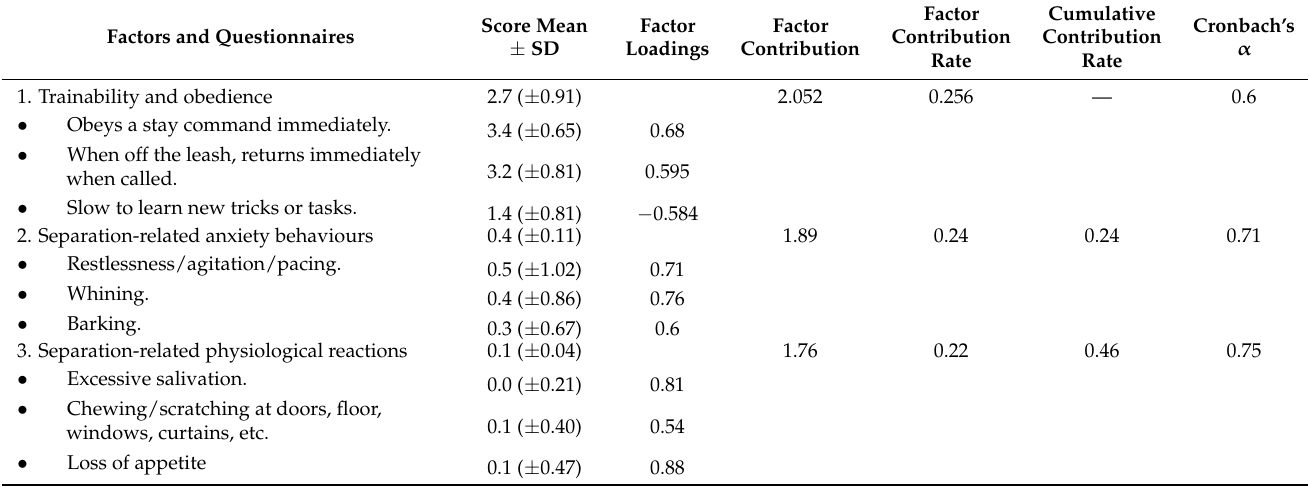
Table 1. Named factors of therapy dog talent and their original questions with factor